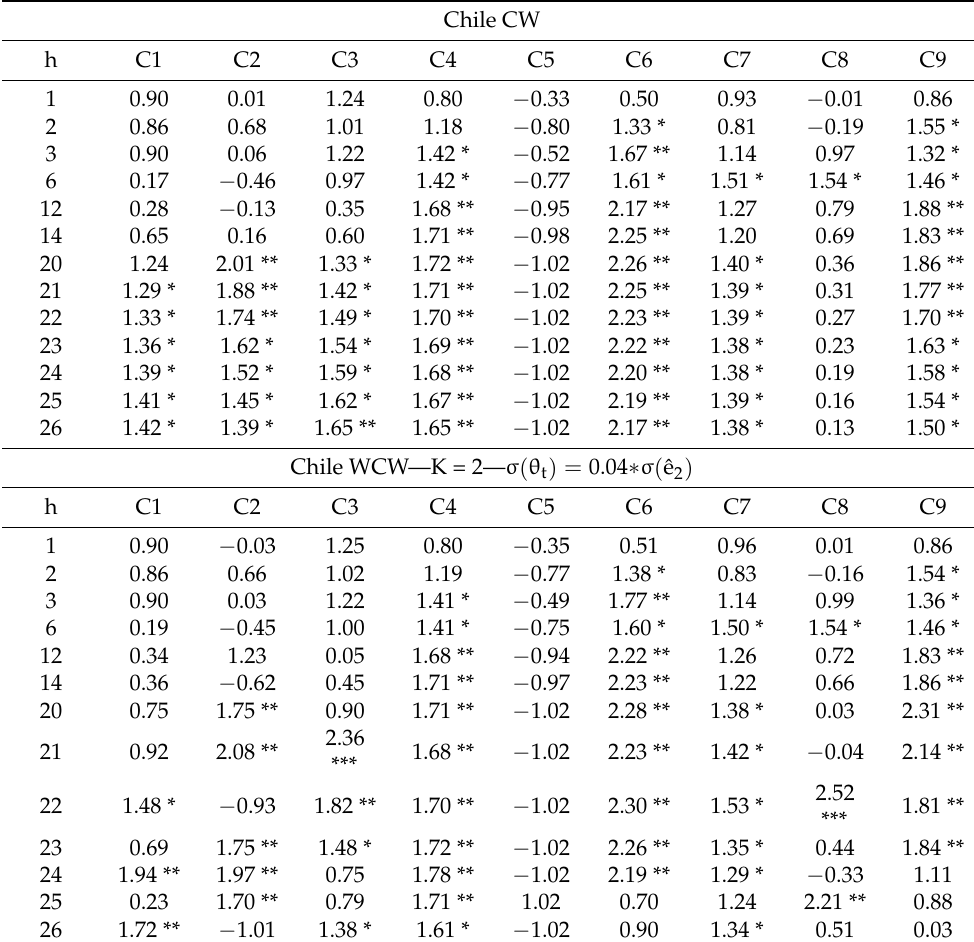
Table 14. Forecasting commodity prices with the Chilean exchange rate. A comparison between CW and WCW in iterated multi-step-ahead